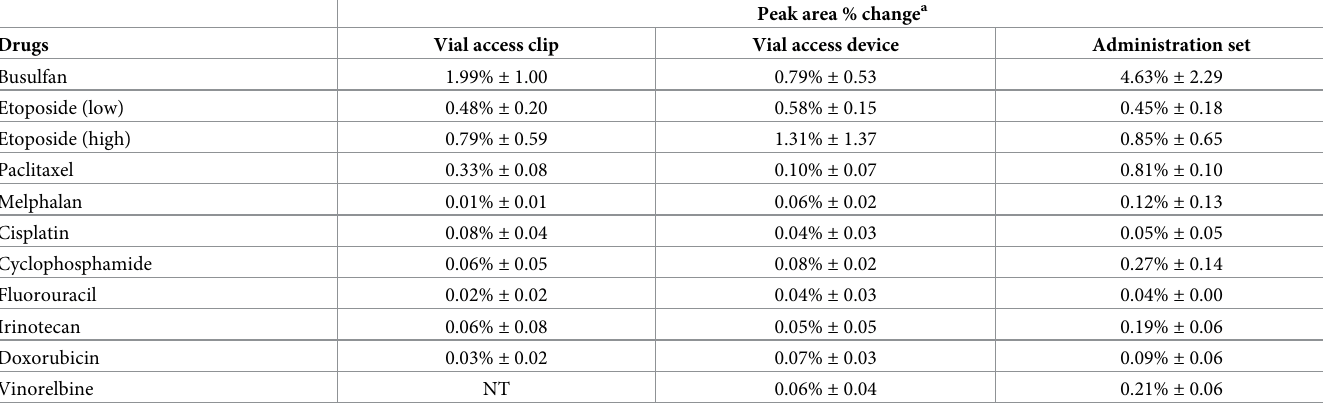
Table 2. Results of drug potency maintenance tests for all CSTD